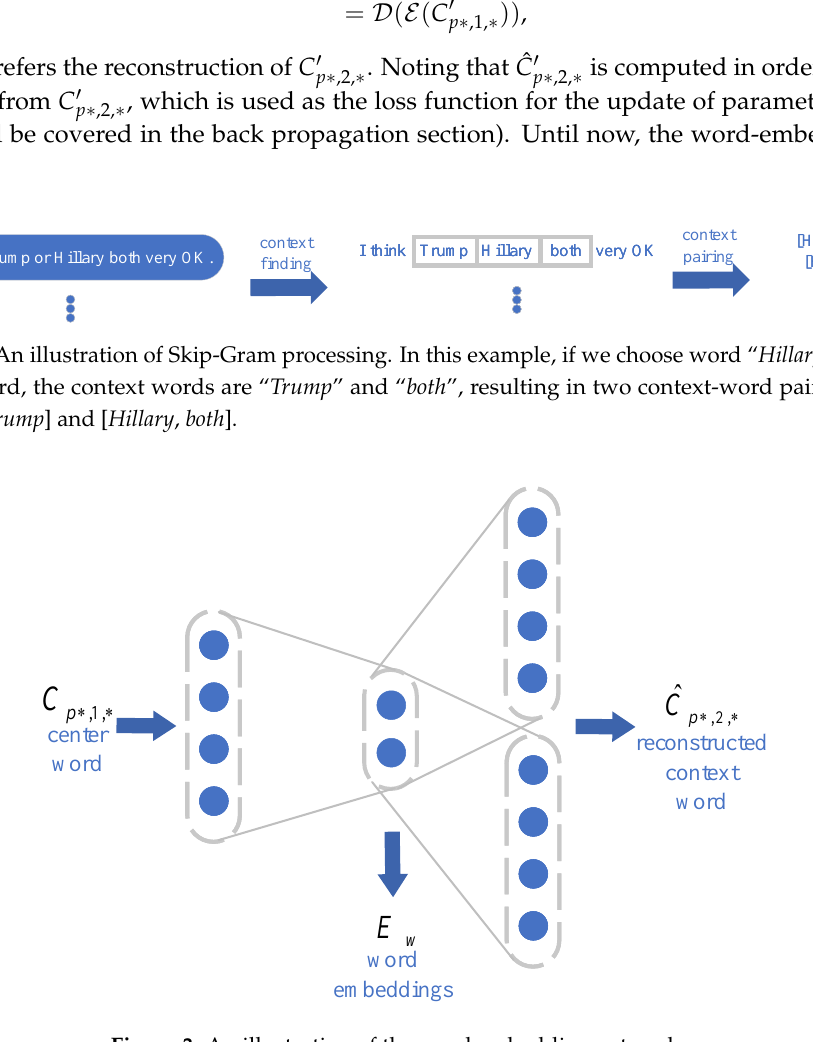
Figure 3. An illustration of the word embedding